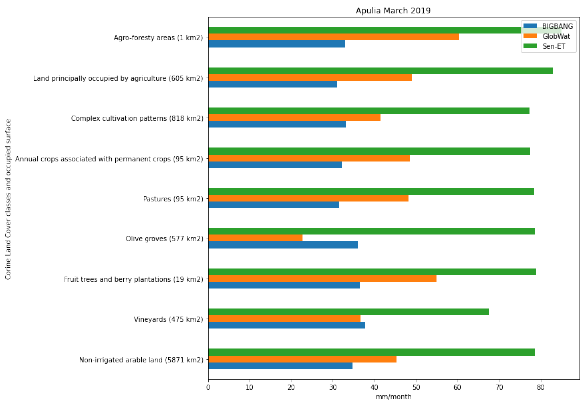
Figure 10. Comparison of ET values generated by BIGBANG, GlobWat and Sen-ET models for the Piedmont area in March 2019.